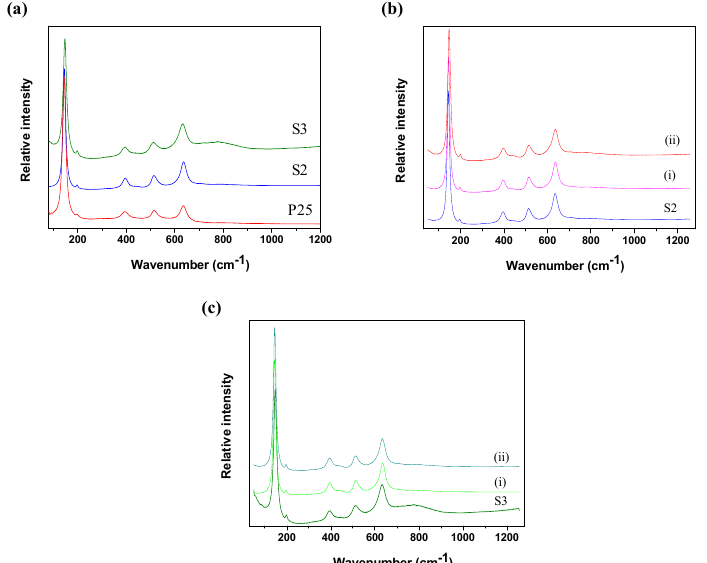
Figure 2. ( a ) Raman spectra of the starting samples before photocatalytic reactions: sample S2, and sample S3 compared to TiO 2 P25. ( b ) Comparison of Raman spectra of the sample S2 before photo ‐ catalytic reaction (denoted by S2), after the reactions using simulated sunlight (i) and after reaction using only visible part of the spectrum (ii). ( c ) Comparison of Raman spectra of the sample S3 before photo-catalytic reaction (denoted by S3), after the reactions using simulated sunlight (i) and after reaction using only visible part of the spectrum (ii).